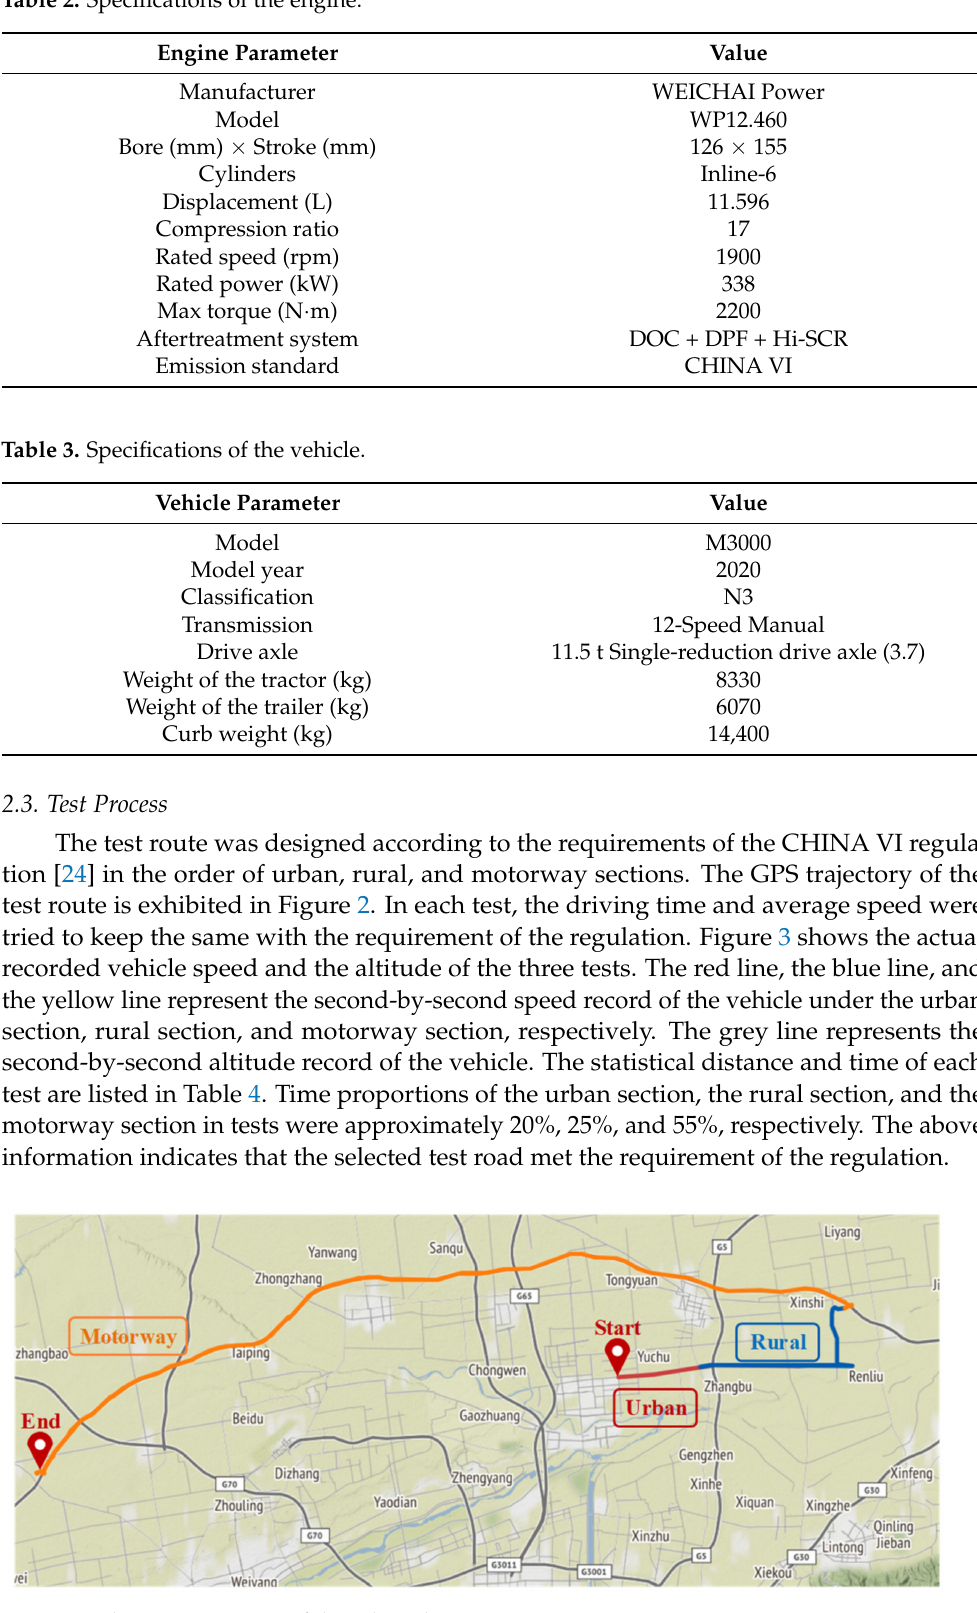
Figure 2. The GPS trajectory of the selected test